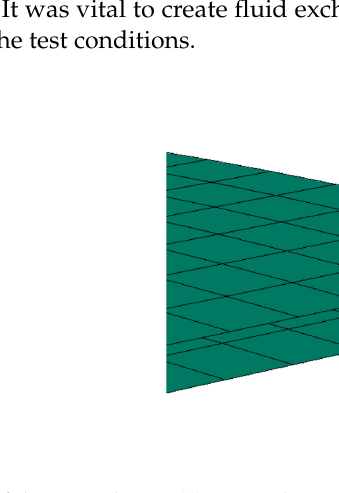
Figure 2. Numerical model of the curved IGU: ( a ) Finite element mesh; ( b ) Detail of the glass–spacer interface. Note: glass panes are shown in green, while spacers are grey.